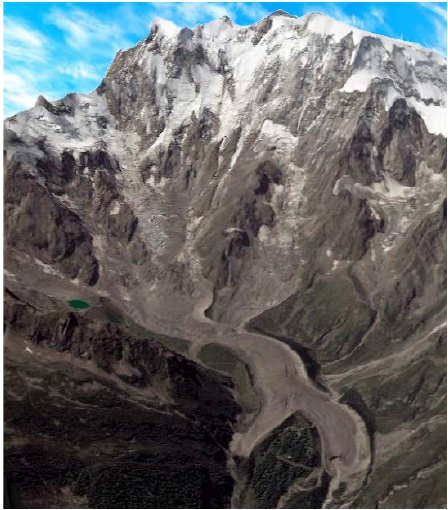
Figure 14. 3D scene based on satellite orthoimagery draped and satellite DSM rendered in ArcGIS Pro